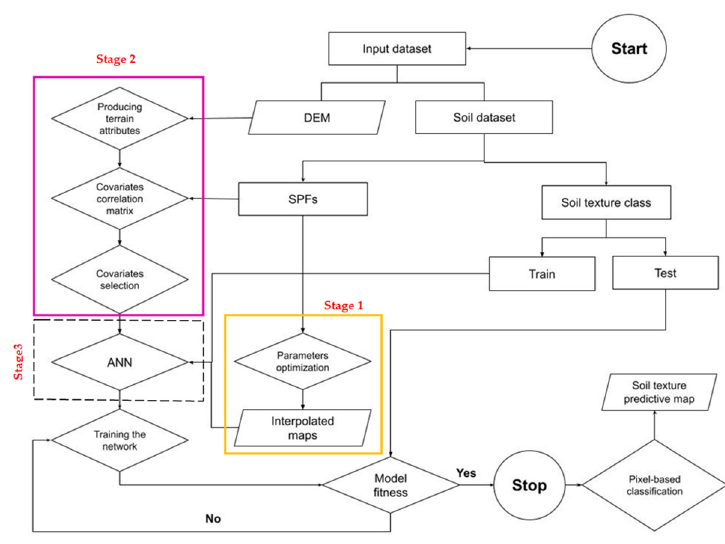
Figure 1. The proposed architecture of the procedure used in this study.